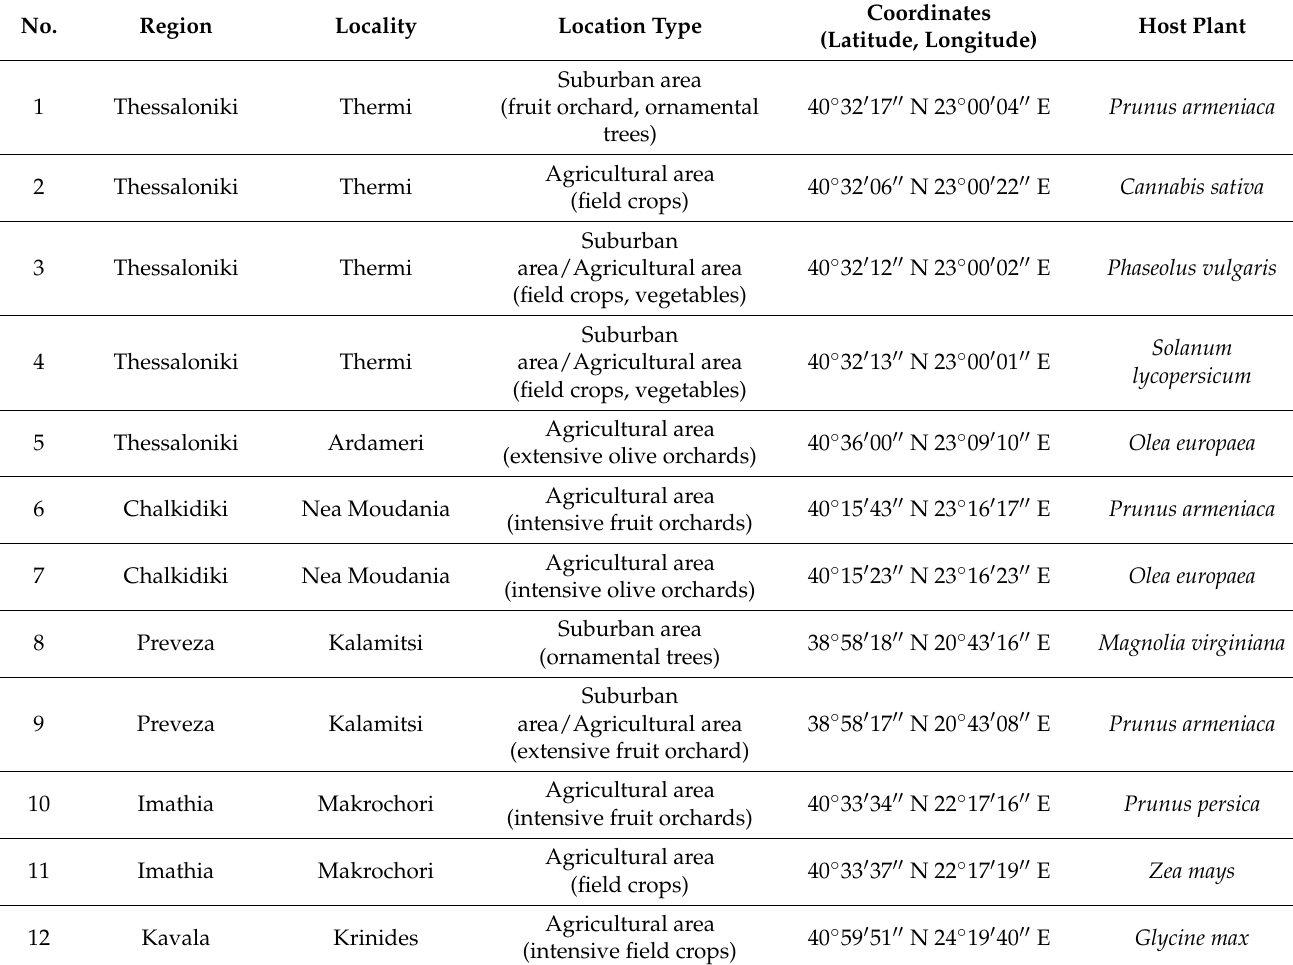
Table 1. Data on field survey from June to October, 2020, in